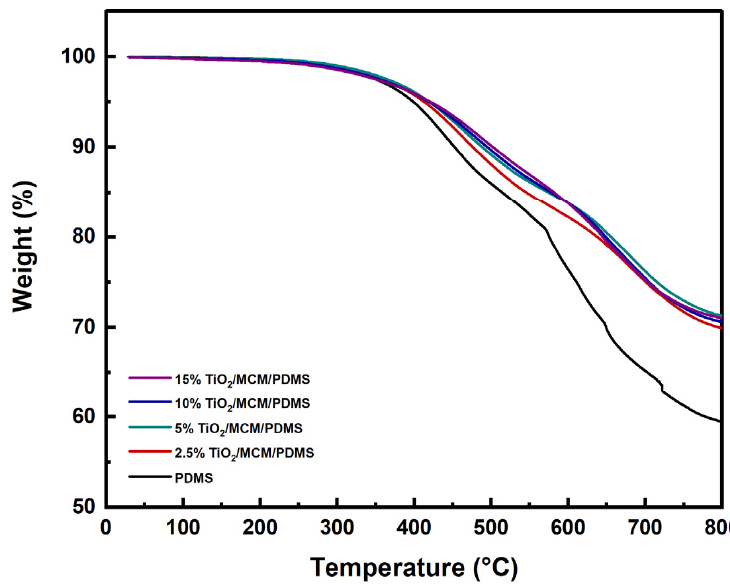
Figure 6. TGA thermograms of PDMS and TiO 2 /MCM/PDMS composites.